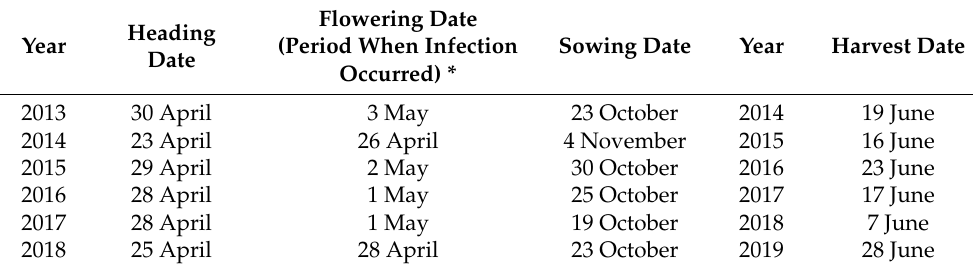
Table 1. The sowing, flowering and harvesting dates of variety Krajišnik in a seven-year